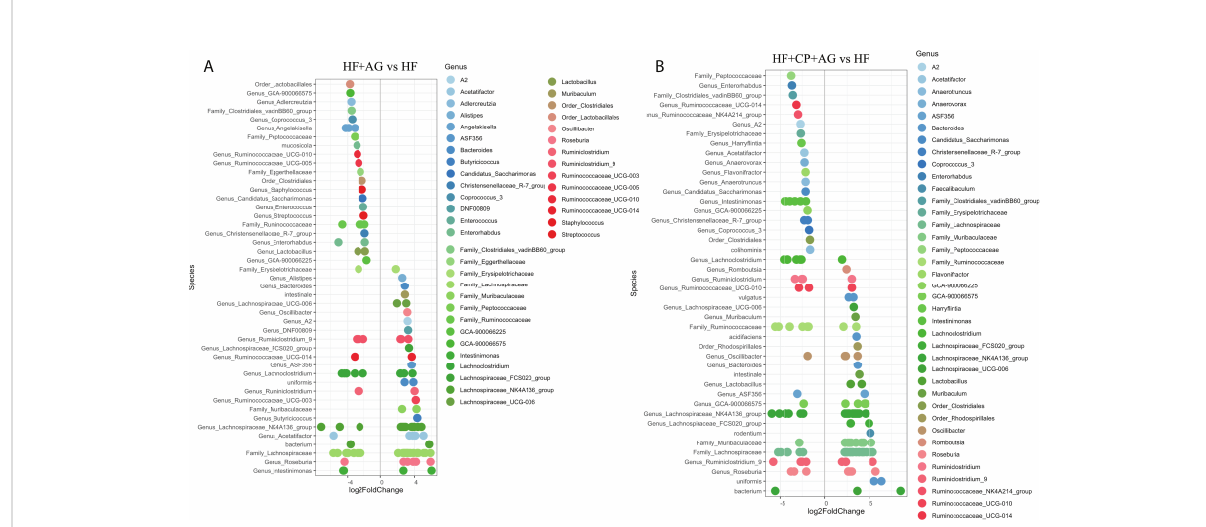
FIGURE 4 Taxa signi fi cantly upregulated and downregulated by agavins and the combination of agavins and cranberry polyphenols in high-fat high-sugar- fed mice. (A) Differential abundance analysis ( DESeq2 ) revealed 45 amplicon sequence variants (ASVs) signi fi cantly modulated in mice fed HF + agavins (HF+AG) relative to HF. (B) Forty-four ASVs were signi fi cantly modulated in mice fed HF + cranberry-polyphenols with agavins (HF+CP +AG) relative to HF mice. ASVs ( p < 0.05, FDR-corrected) are represented by single data points (with some data points overlapping) within each genus grouped on the x-axis, and by color fi tting to which taxonomic family the ASVs belong. Data are plotted as log2 fold change. n = 12 mice per group. ASVs to the right of the zero line are more abundant and ASVs to the left of the zero line are less